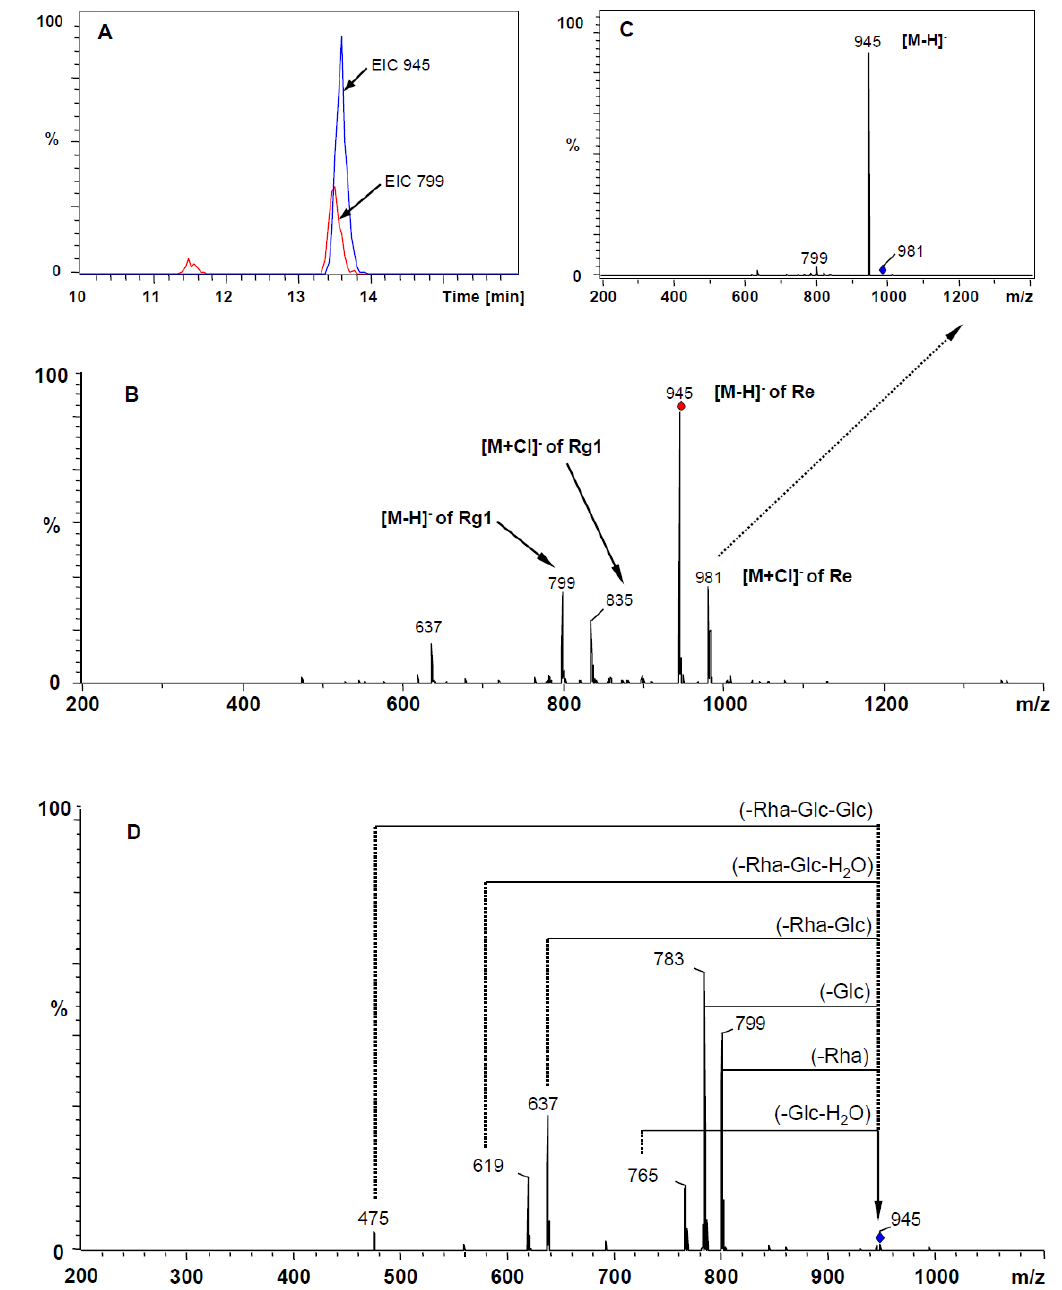
Figure 3. Mass spectra of ginsenoside Rg and Re in negative mode. ( A ) EIC of m/z 945 1 and 799; ( B ) HPLC-ESI-MS spectra; ( C ) the CID spectra of adduct ion [M+Cl] − of ginsenoside Re at m/z 981; ( D ) the CID spectra of parent ion [M − H] − of ginsenoside Re at m/z 945 (The deprotonated ion is indicated by a vertical